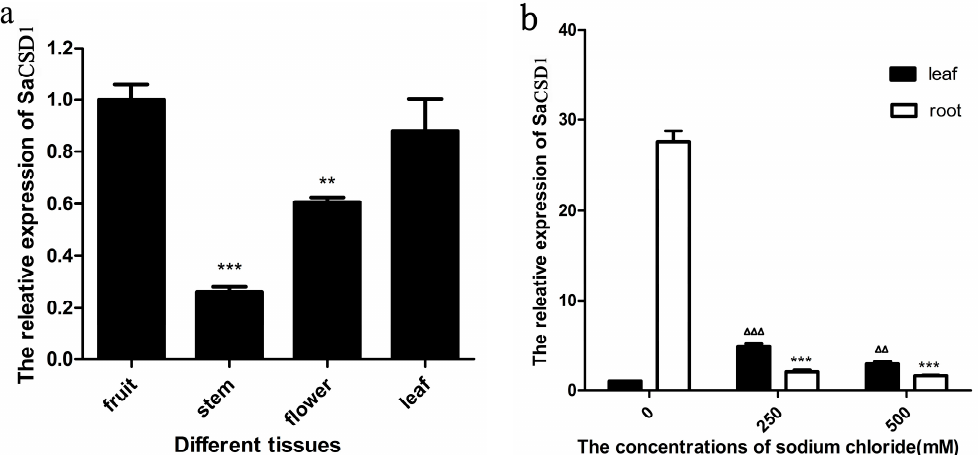
Figure 4. Real-time PCR analysis of the SaCSD1 transcript. ( a ) Expression of SaCSD1 in different organs. The highest expression (fruit) was set as 1.0 and ** p < 0.01 *** p < 0.001 means significant differences from it; ( b ) Expression of SaCSD1 in roots and leaves treated with NaCl solutions. The blank group of leaves was set as 1.0 and, ∆∆ p < 0.01, ∆∆∆ p < 0.001 means significant differences from it, *** p < 0.001 means significant differences from the blank group of roots. CSD1 Data are presented as the mean ± SD of three independent experiments.